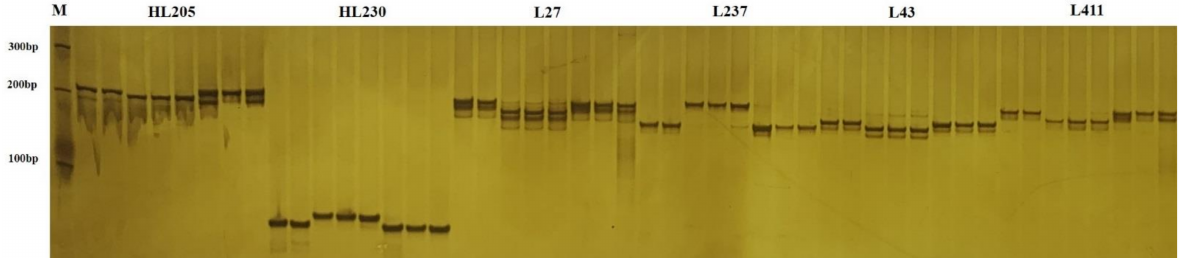
Figure 1. Detection of eight cabbage lines by using six BoHL2 markers. Six InDel markers (HL205, HL230, L27, L237, L43 and L411) showed 100% accuracy in distinguishing the eight cabbage